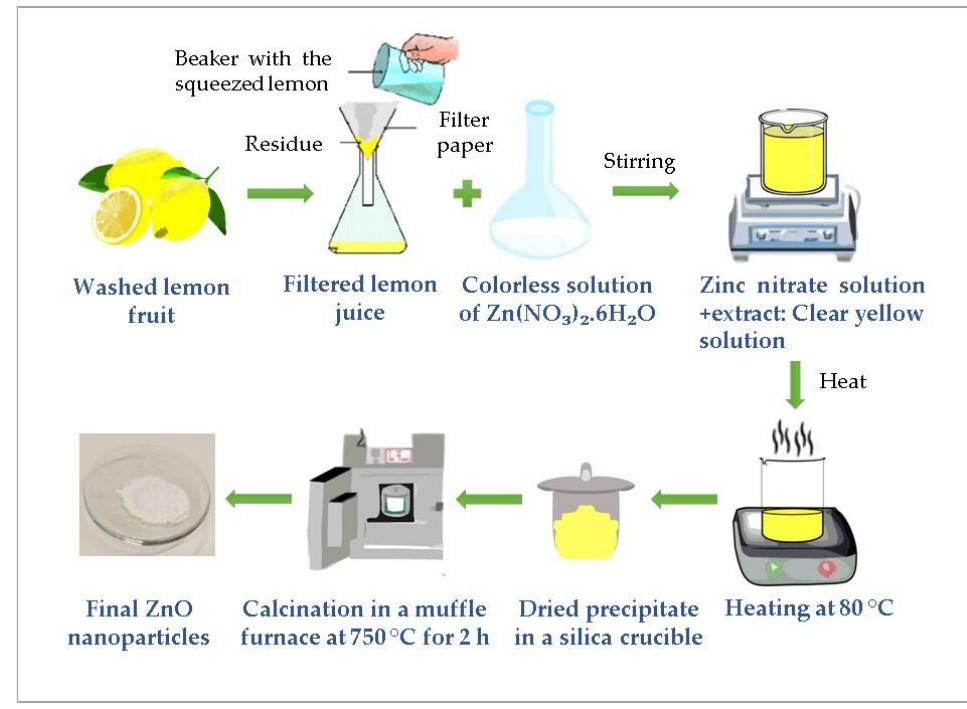
Figure 1. Illustration of the green synthesis process of ZnO nanoparticles using lemon juice.